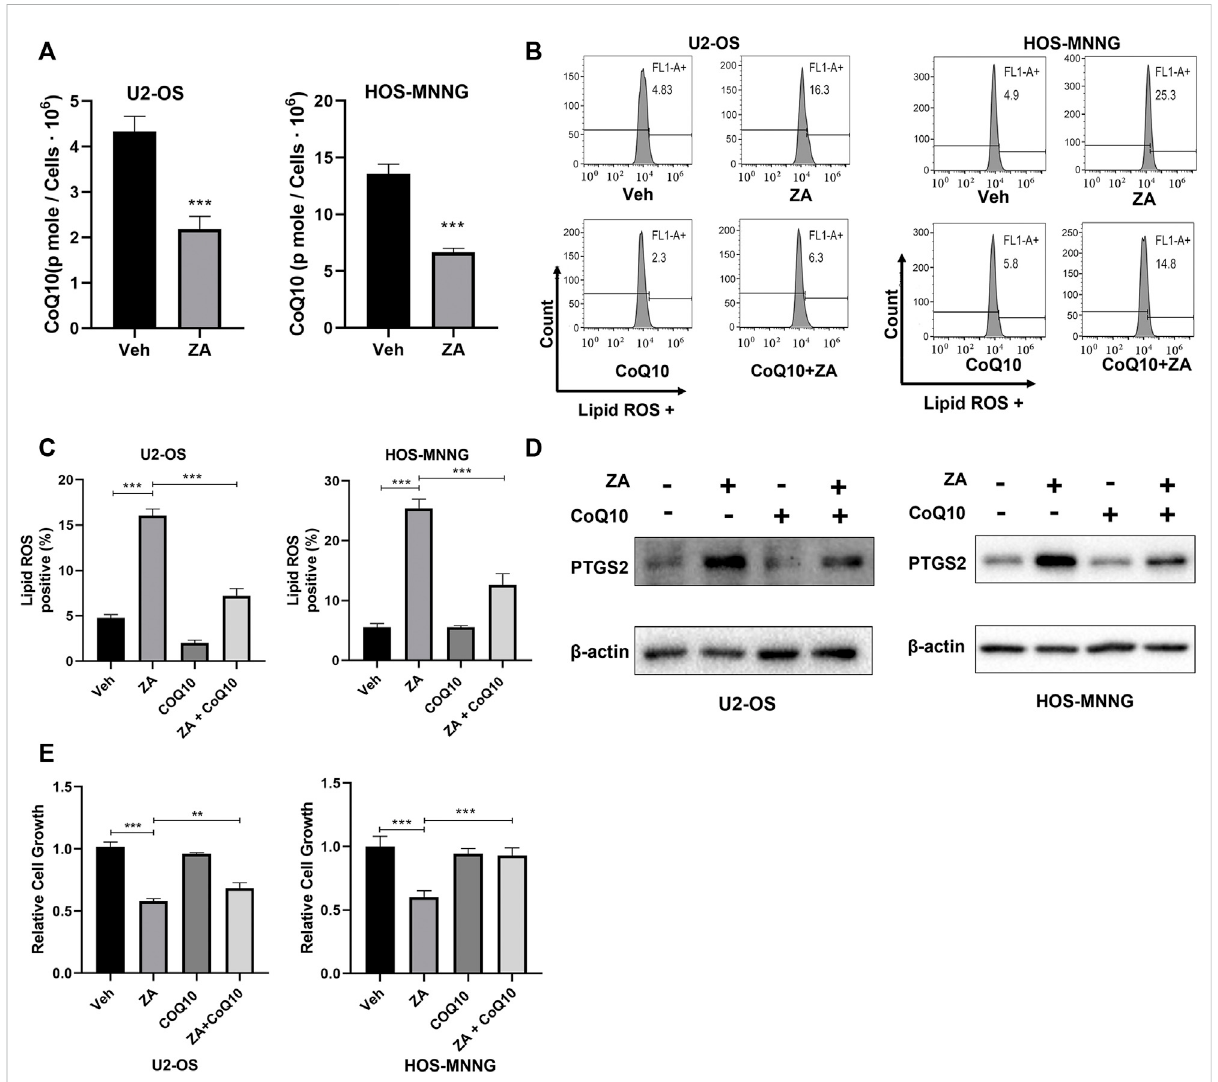
Zoledronic acid induces ferroptosis and inhibits cell growth in part through reducing CoQ10 content in osteosarcoma cells. (A) ZA treatment reduces CoQ10 level in osteosarcoma cells. U2-OS and HOS-MNNG cells were treated with vehicle (Veh) and ZA (20 μ M) for 24 h, and broken by ultrasound. CoQ10 wasextracted by ethanol and was quanti fi ed byHPLC. (B,C) Addition of exogenous CoQ10inhibits ZA-enhanced lipid ROS level. Cells were treated with Veh, ZA (20 μ M) and CoQ10 (5 μ M) alone or together for 24 h and lipid ROS level was analyzed. (C) Quantitation and statistical analysis of the data shown in (B) . (D) Addition of exogenous CoQ10 decreases ZA-enhanced PTGS2 protein level. Cells were treated with Veh, ZA (20 μ M) and CoQ10 (5 μ M) alone or together for 24 h. Western blot was used to detect PTGS2 protein expression. (E) Exogenous CoQ10 prevents ZA-induced decrease in cell growth. Cells were treated with Veh, ZA (20 μ M), or CoQ10 (0.75 μ M) alone or together for 72 h. Then, the cell growth was examined by CCK8 reagent and analyzed. The means ± SEM are indicated, n = 3. * p < 0.05, ** p < 0.01, *** p <